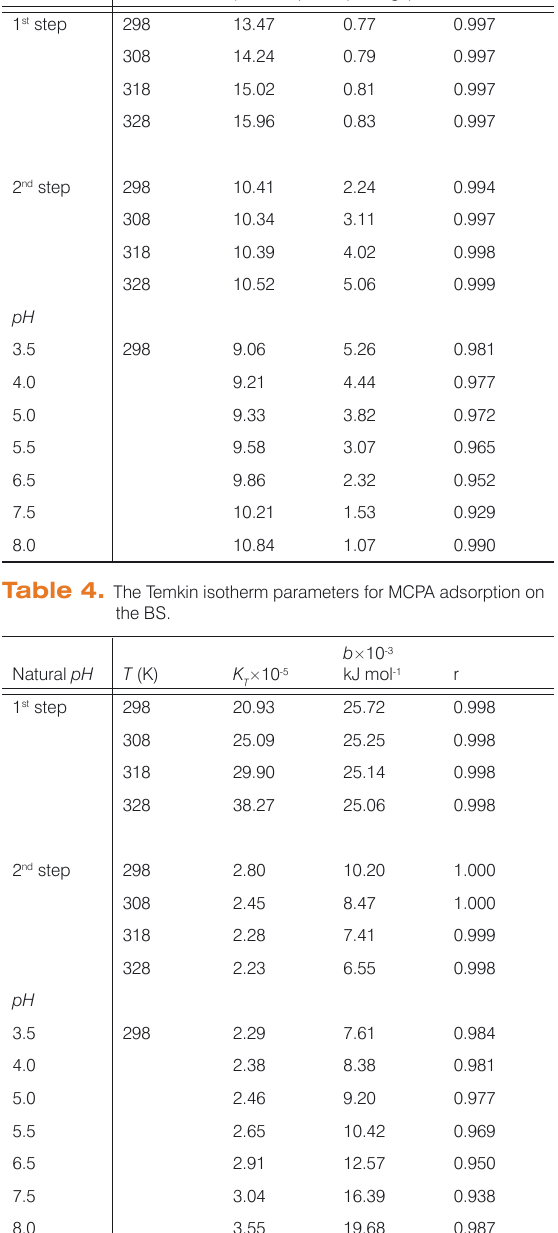
Table 2. The D-R isotherm parameters for MCPA adsorption on the BS. Natural pH